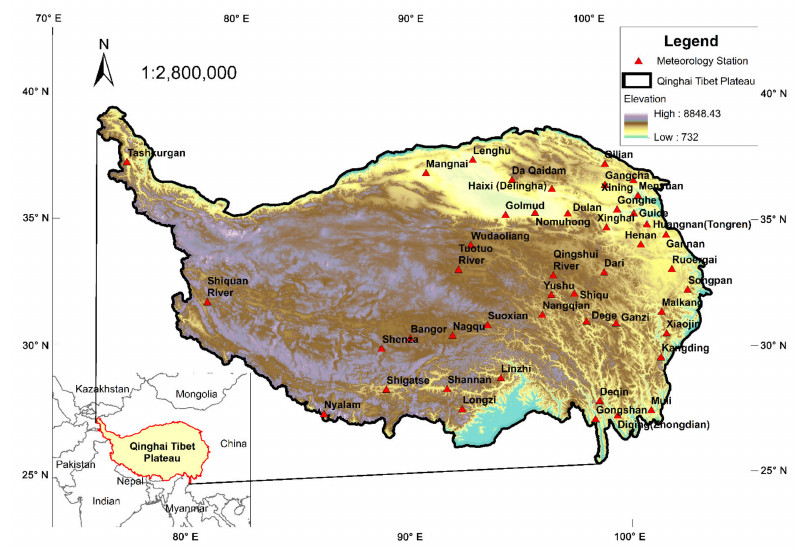
Figure 1. Scope, altitude and geographical location of study area, and distribution of meteorologi- cal stations.